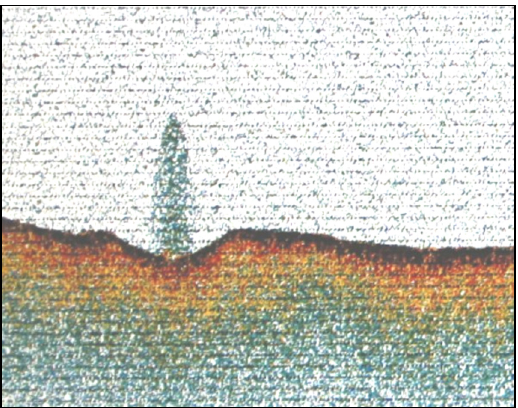
Figure 3. An 80-m-high episode of degassing in the proximity of the Marsili seamount crest recorded with chirp investigations (courtesy of